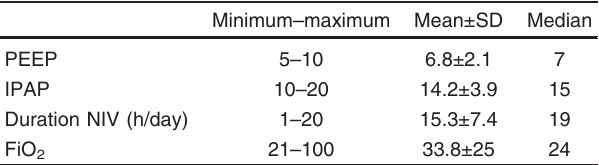
Table 1 BiPAP settings in group II ( n =